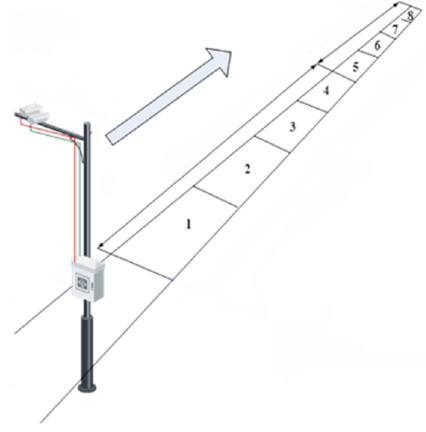
Figure 1. The method of camera installation.